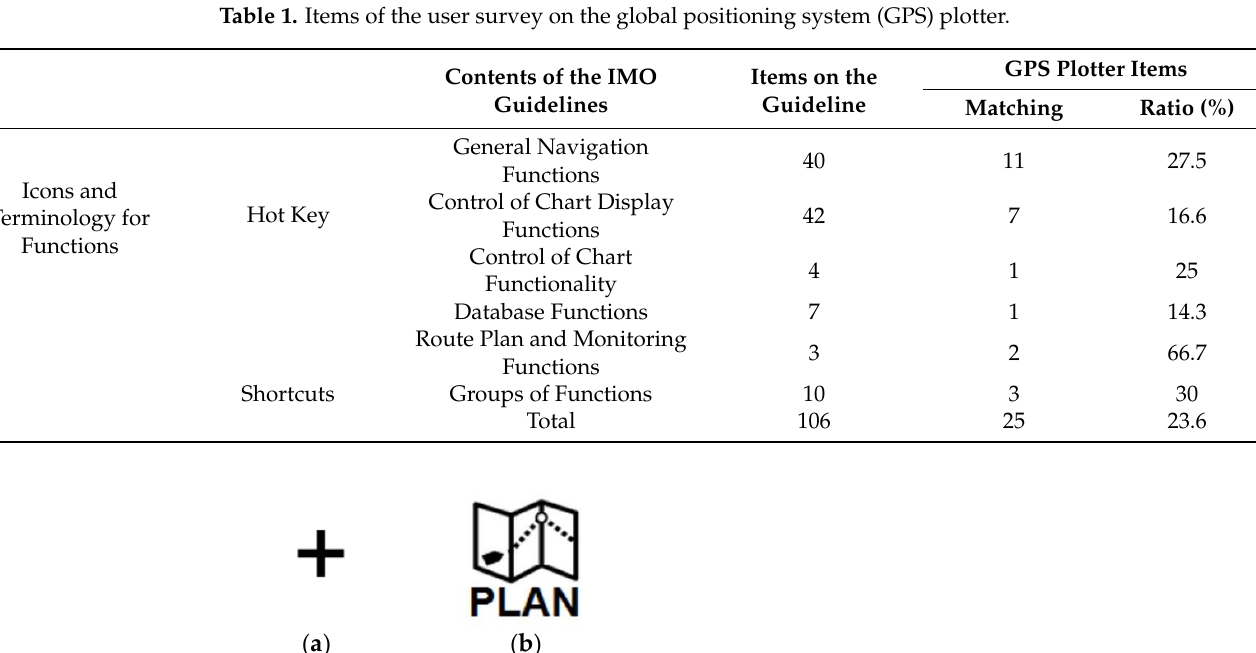
Figure 2. ( a ) An icon for hot keys (zoomed in); ( b ) an icon for shortcut (Route plan) [5]. Table 1. Items of the user survey on the global positioning system (GPS) plotter.